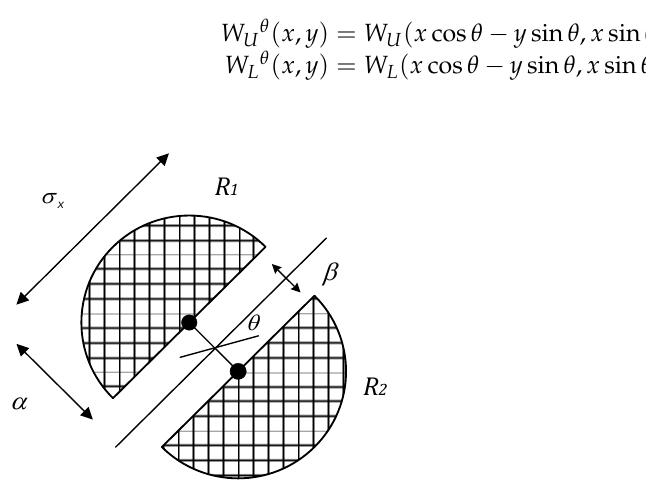
Figure 1. Filter configuration of edge detector that is Gauss – Gamma-shaped.